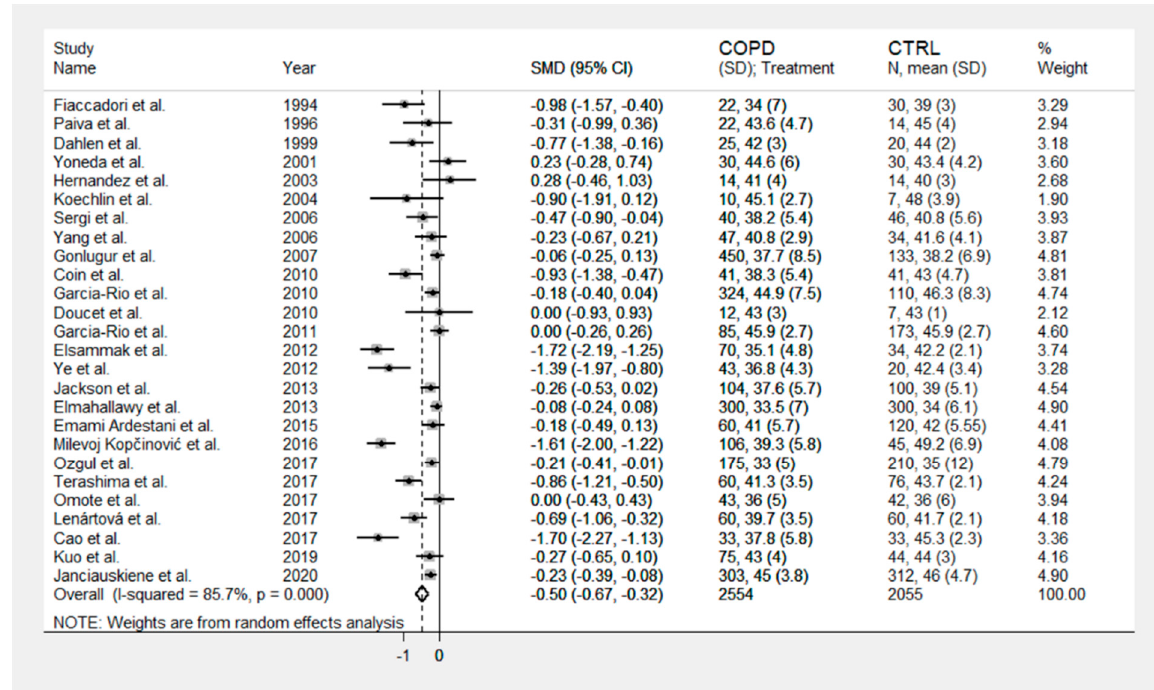
Figure 2. Forest plot of studies examining serum albumin in chronic obstructive pulmonary disease (COPD).